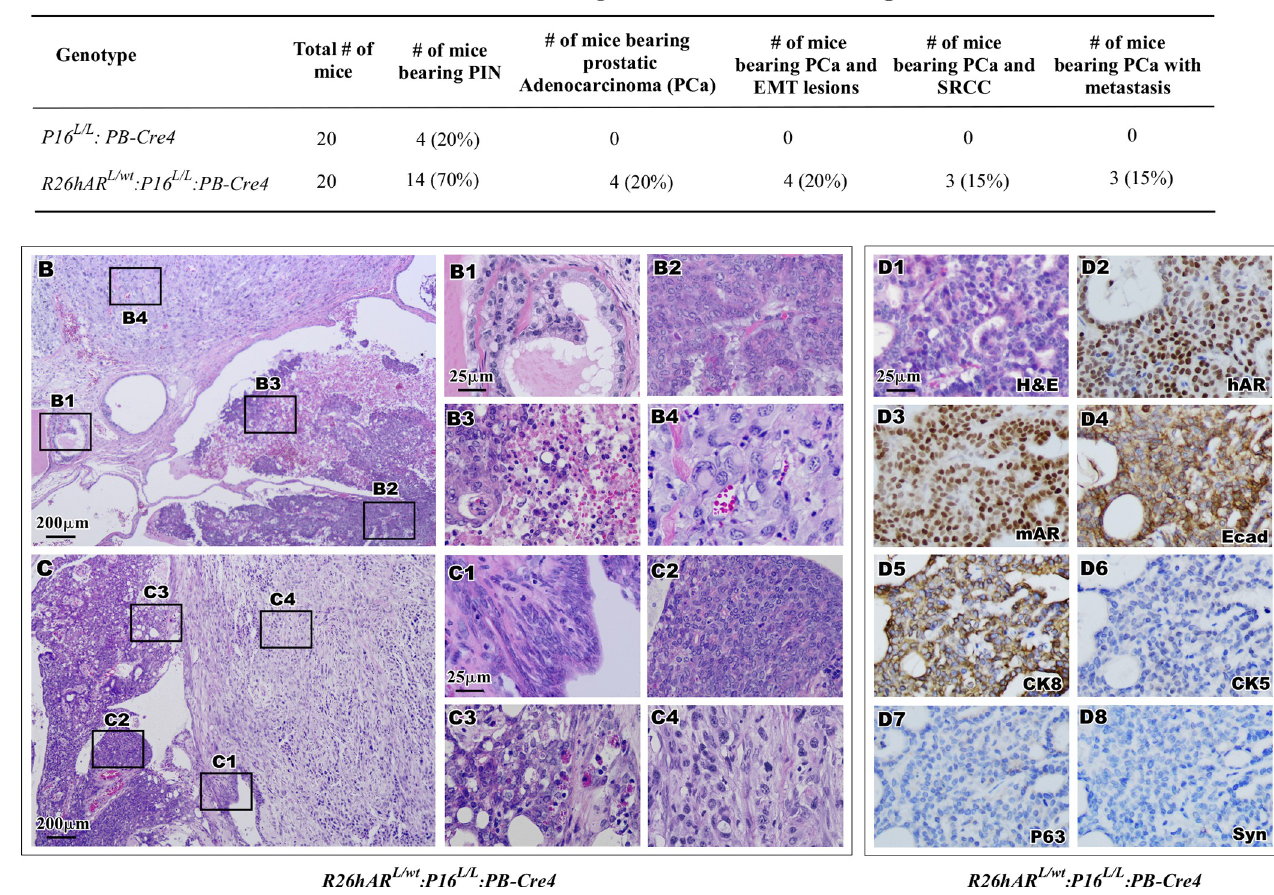
PLOS ONE | https://doi.org/10.1371/journal.pone.0211153 January 24,